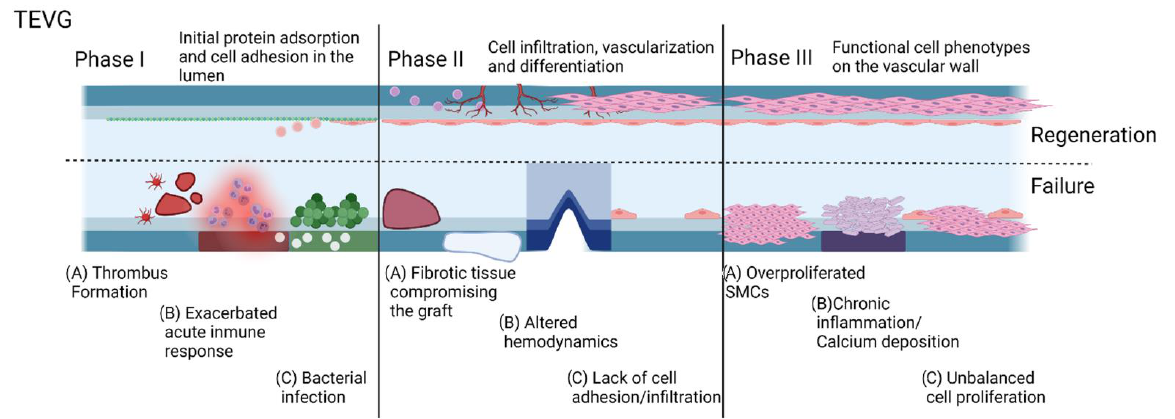
Figure 10. Macroscopic implication of causes of failure. Phase 1: the inflammatory and peri-implantation conditions have been stabilized; there is an initial protein adsorption and cell adhesion in the lumen. The causes of failure might be (A) thrombotic events, (B) an exacerbated acute immune response and (C) bacterial infection. Phase 2: the graft has overcome the first phase, and the hemodynamic conditions are homogeneous. The causes of failure include the (A) fibrotic tissue generation in the thrombus or in the periphery of vascular grafts, (B) altered hemodynamic changing the cell phenotype expression, and (C) the lack of cell adhesion or infiltration avoiding the vascular wall repopulation. During this phase, the chronic inflammation responses are led by fibroblasts and foreign body giant cells to encapsulate the biomaterial. Phase 3: Once the endothelial lining covering the inner surface is established, the cell and remodeling of the vascular wall will occur. The causes of failure might be due to (A) the excessive SMC proliferation (hyperplasia) by a compensation mechanism of the hemodynamic conditions, (B) calcification of the graft from a chronic inflammatory response, and (C) an unbalanced cell proliferation due to a lack of bioactive signals. After 2 to 5 years, the lack of balance on the regenerative signals and the cell responses will maintain the chronic inflammation state and the failure of the vascular graft will occur. For all the cases, the development of a functional endothelial phenotype will promote proinfllammatory pathways while at the same time that enhancing regeneration. The current challenge is to balance the different cell responses to improve endothelialization (Created with BioRender.com, accessed on 3 February 2022).